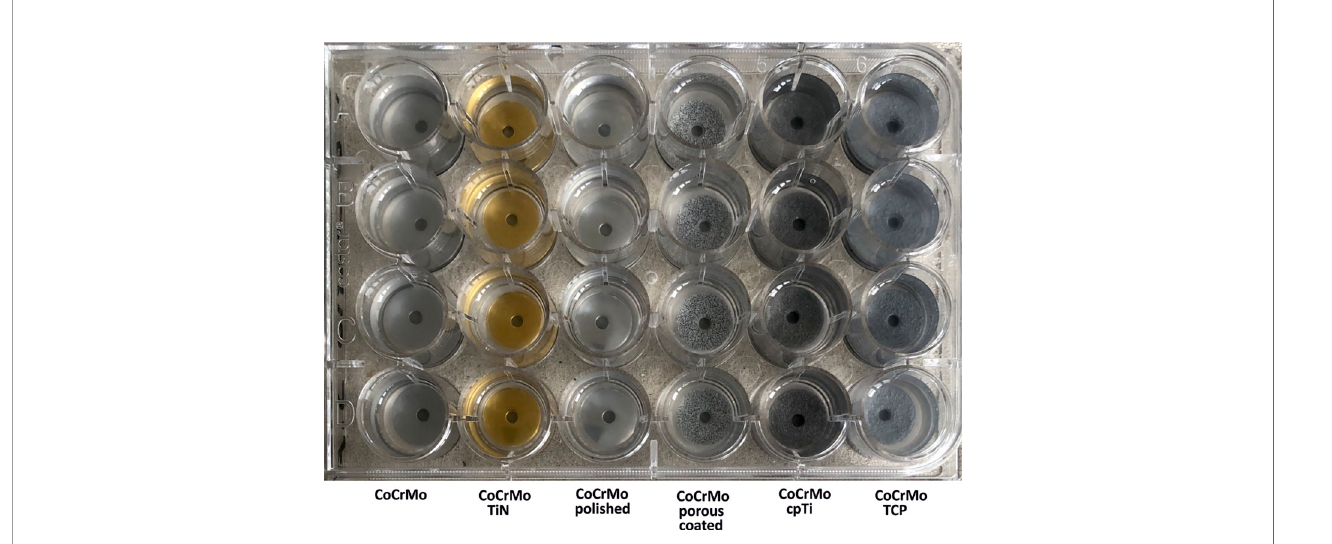
FIGURE 1 | Cell culture plate with the different alloy